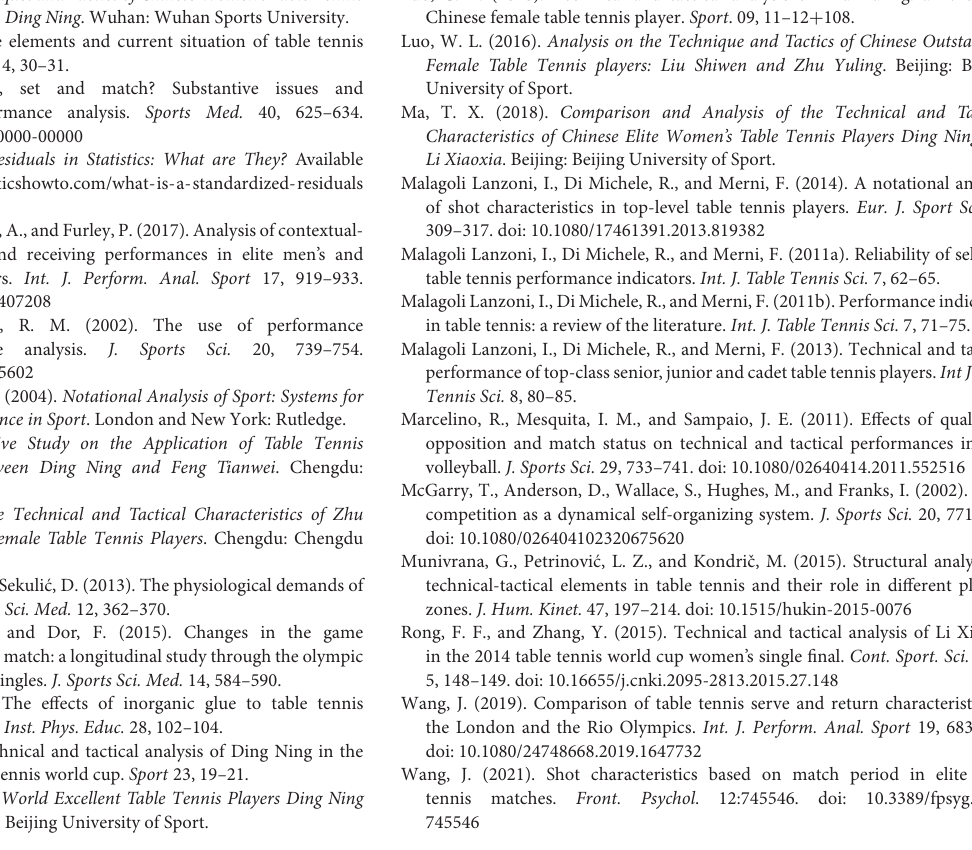
table tennis performance indicators. Int. J. Table Tennis Sci. 7, 62–65. MalagoliLanzoni,I.,DiMichele,R.,andMerni,F.(2011b).Performanceindicators in table tennis: a review of the literature. Int. J. Table Tennis Sci. 7, 71–75. Malagoli Lanzoni, I., Di Michele, R., and Merni, F. (2013). Technical and tactical performanceoftop-classsenior,juniorandcadettabletennisplayers. IntJTable Tennis Sci. 8,